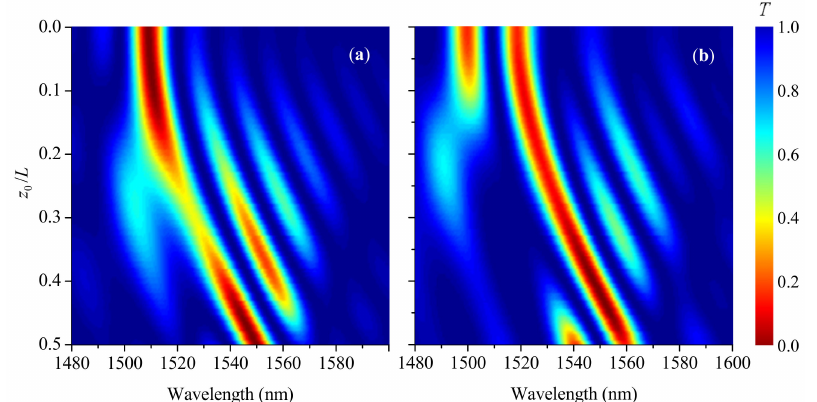
Figure 11. Evolution of transmission spectra with transition point z 0 moving through the reflective LPFG for strain s 0 = 18 with ( a ) zero phase shift and ( b ) π